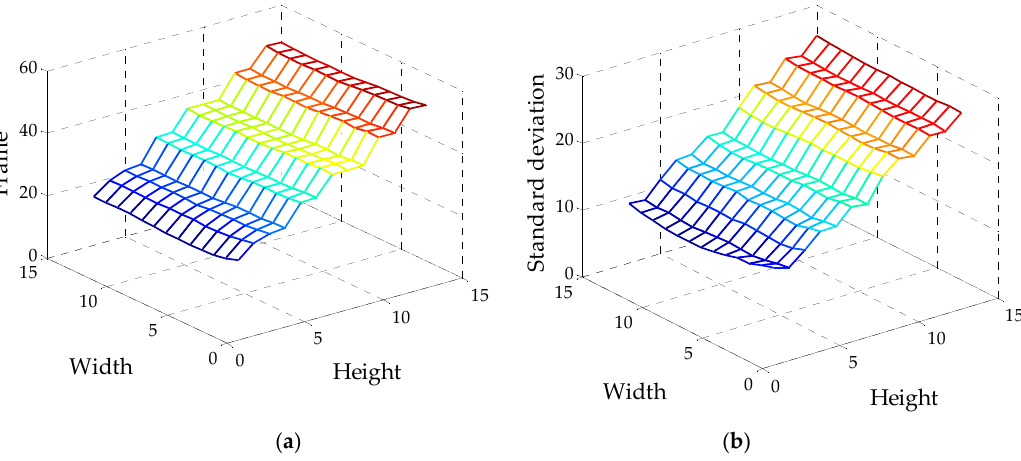
Figure 22. The maximum standard deviation surface related to width and height: ( a ) The maximum standard deviation surface for #1; ( b ) The maximum standard deviation surface for #2.